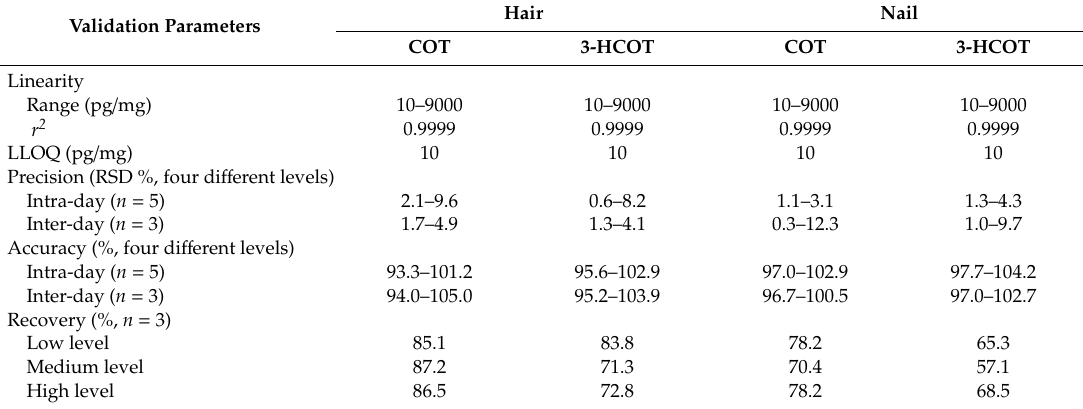
Figure 3. LC–MS / MS chromatograms of target analytes and internal standards spiked in: ( A ) blank hair; and ( B ) blank nail samples. Table 1. Validation summary for the proposed method.